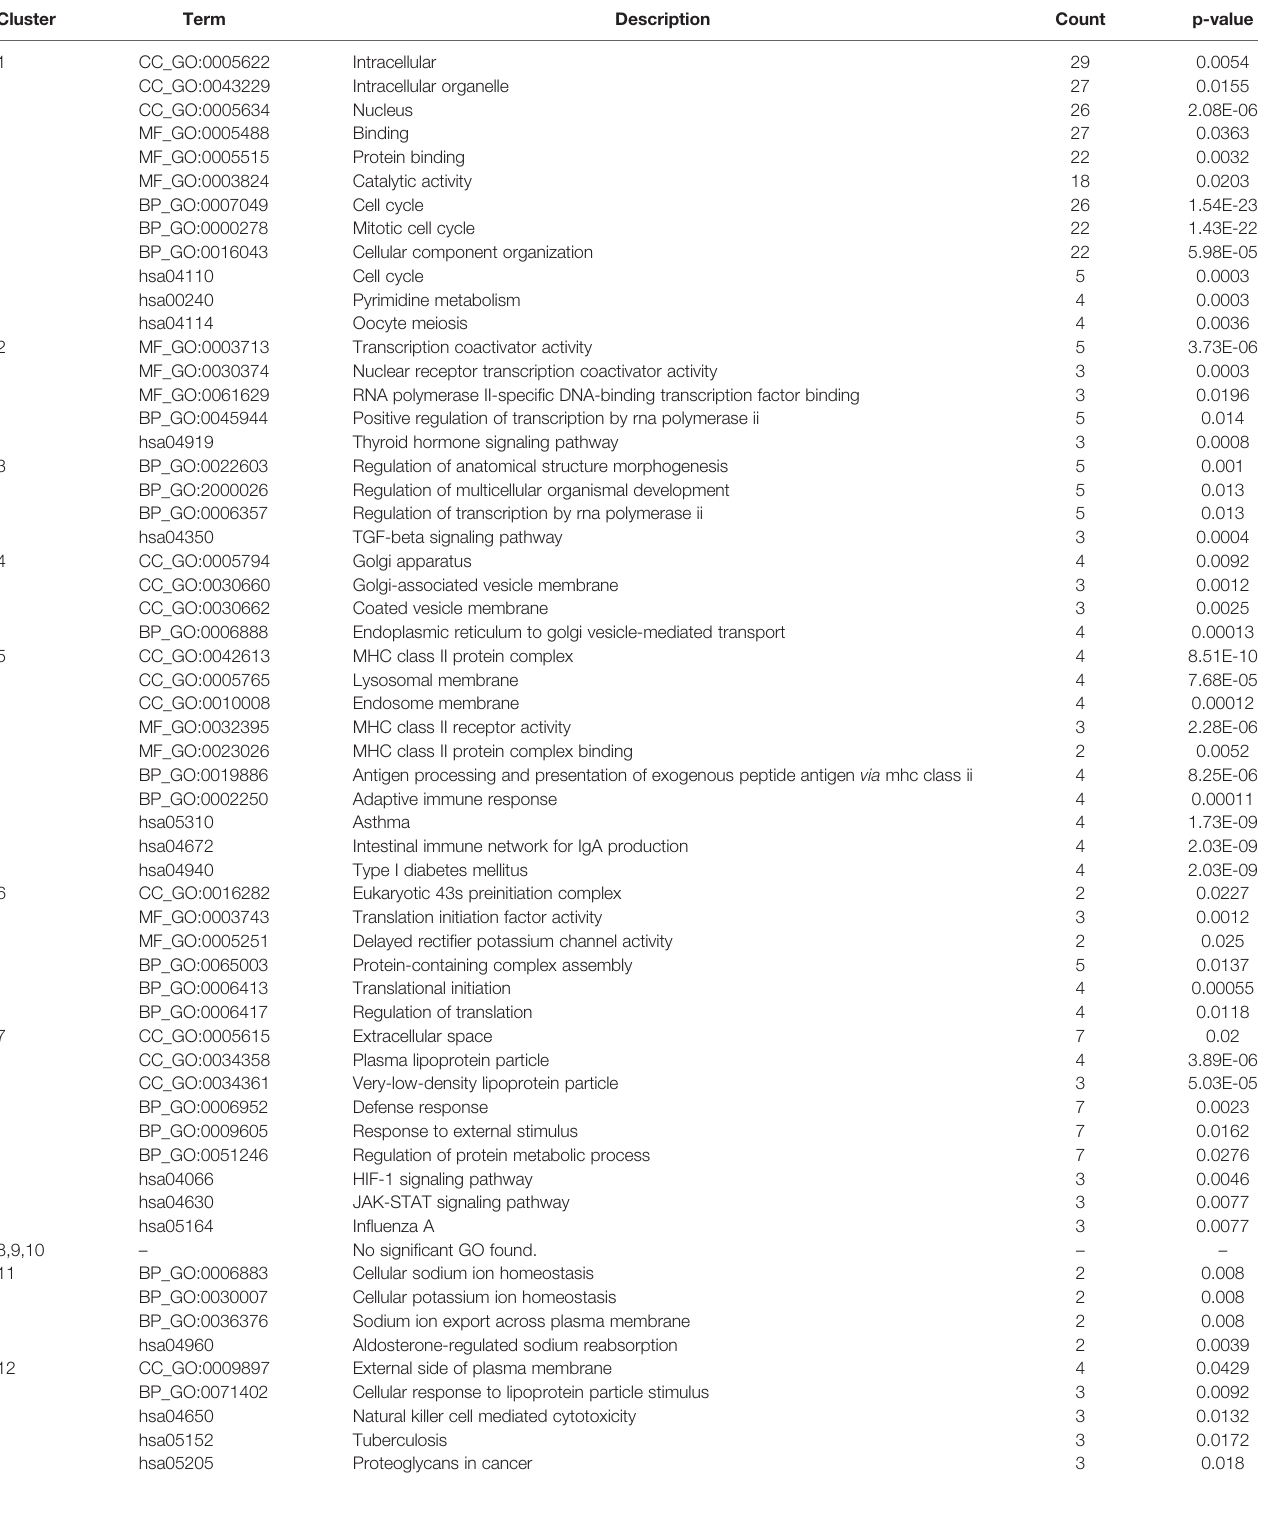
TABLE 3 | Functional annotation clustering on the clusters identi fi ed from DEGs.